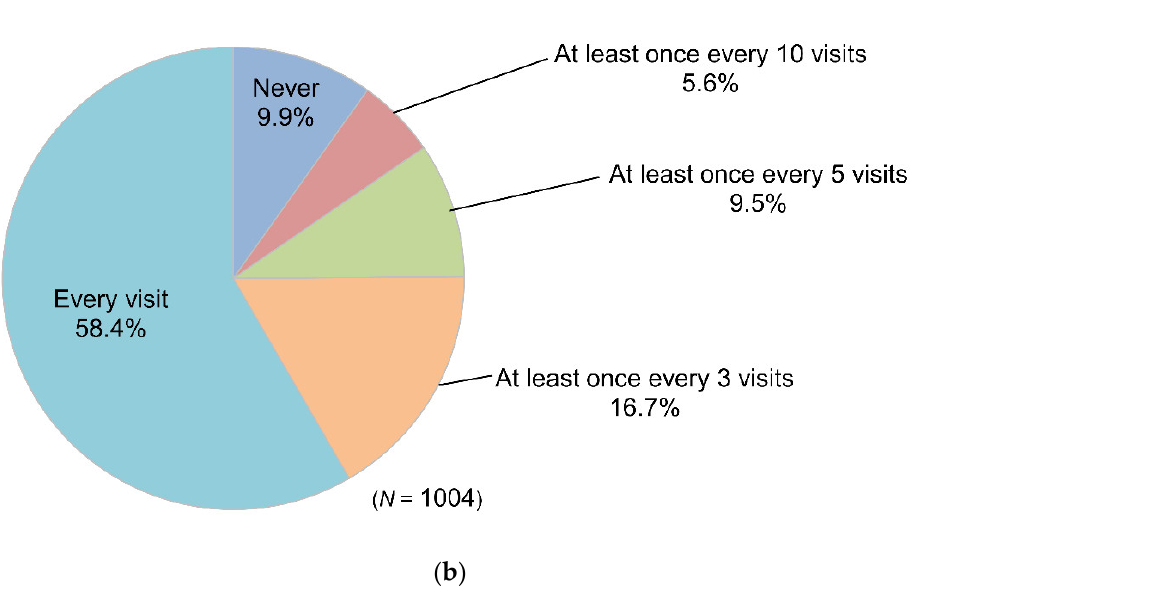
Figure 2. Results of survey questions ( a ) (Q1): Effectiveness, side effects of medication, and communication with physician for overactive bladder medical care; ( b ) (Q2): frequency of talking with your physician about symptoms and treatments related to urination; and ( c ) (Q3): satisfaction with current overall medical care for overactive bladder.